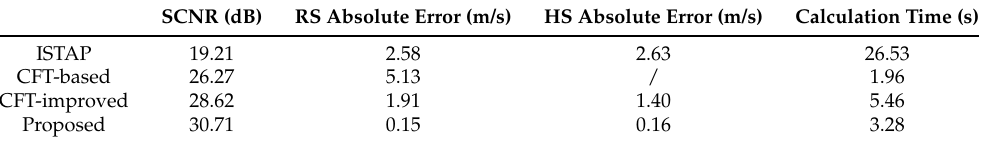
Table 3. Performance assessment for different methods.